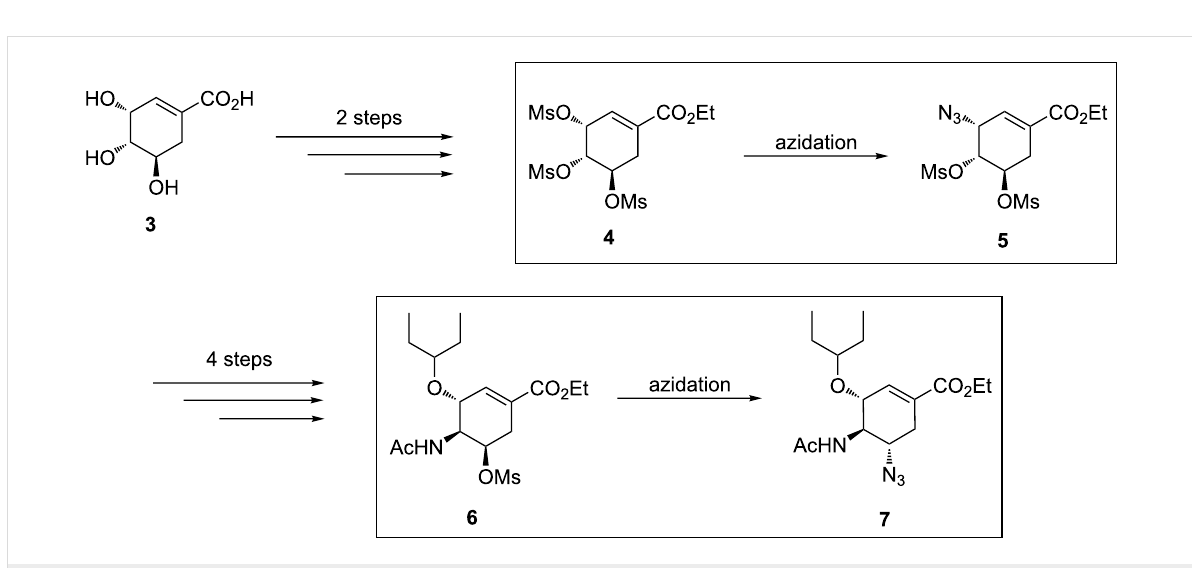
Scheme 2: Azide chemistry in the synthesis of